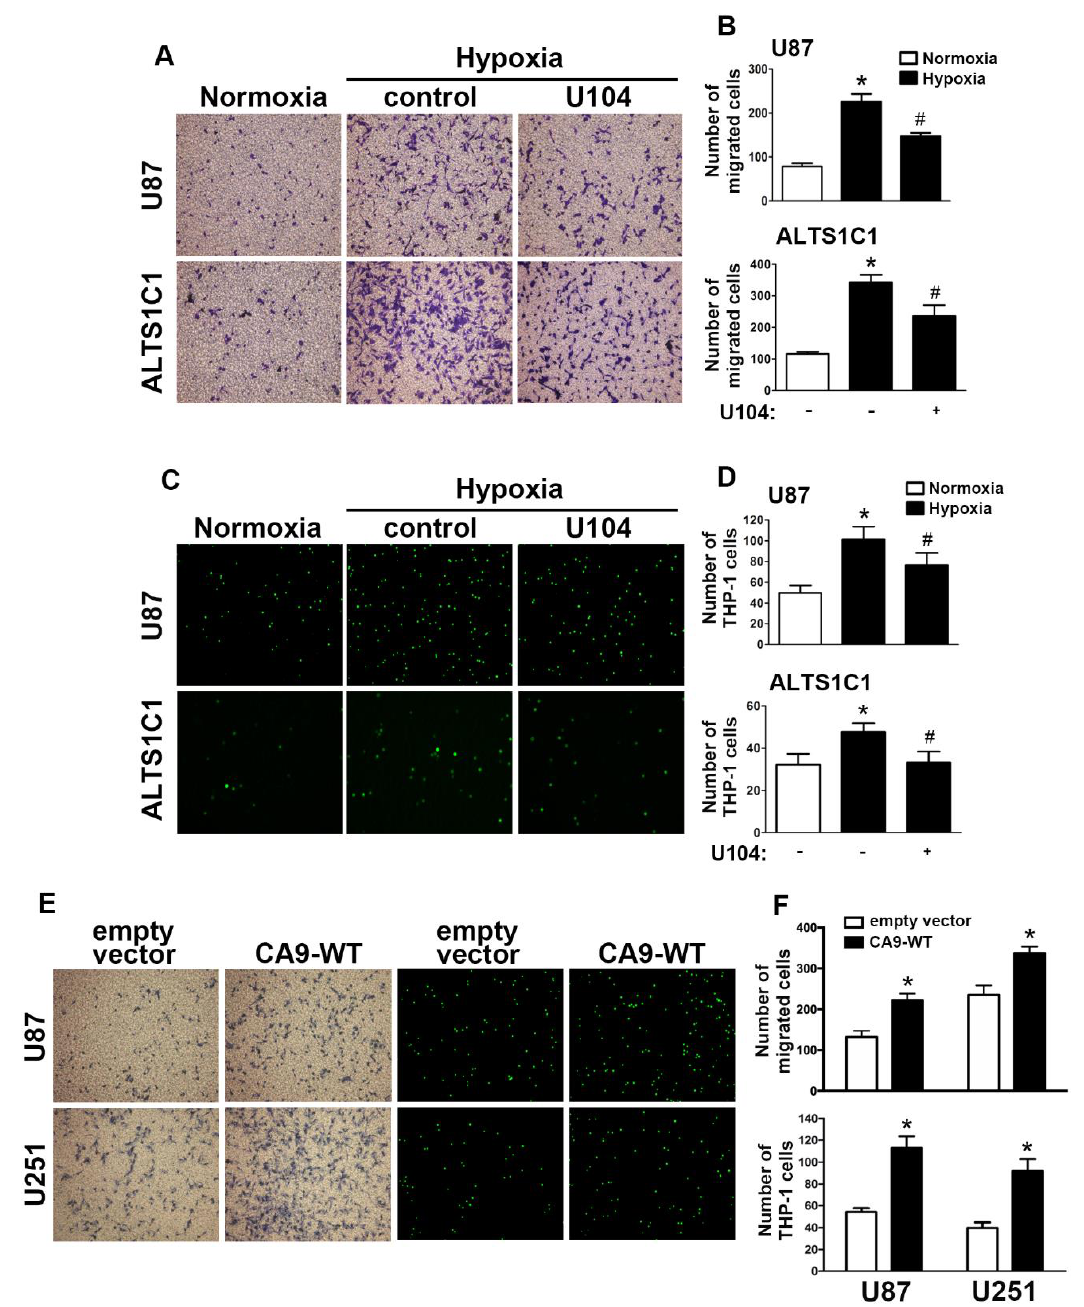
Figure 2. CAIX is involved in the hypoxia-enhanced GBM migration and monocyte adhesion. ( A ) U87 and ALTS1C1 were treated with a CAIX inhibitor (U104; 3 μM) for 30 min and exposed to hypoxic conditions (1% oxygen (O 2 )), and in vitro migration activities were measured after 24 h with a transwell assay and then visualized using a digital camera. ( B ) The quantification of U87 (upper panel) and ALTS1C1 (lower panel) migration by the number of cells that migrated to the underside of the filter. ( C ) U87 and ALTS1C1 were treated with a CAIX inhibitor (U104, 3 μM) for 30 min and exposed to hypoxic conditions (1% O 2 ) for 24 h. BCECF-AM-labeled-THP-1 was added to U87 and ALTS1C1 for 30 min, and subsequently, the adherence of THP-1 was measured by fluorescence microscopy. ( D ) The quantification of monocyte adhesion abilities by THP-1 cell adhesion on U87 (upper panel) or ALTS1C1 (lower panel). * p < 0.05 compared with the normoxia group. # p < 0.05 compared with the hypoxia group. A two-way analysis of variance with a post-hoc Bonferroni test was used to examine the significance of the mean. ( E ) U87 and U251 cells were transfected with empty